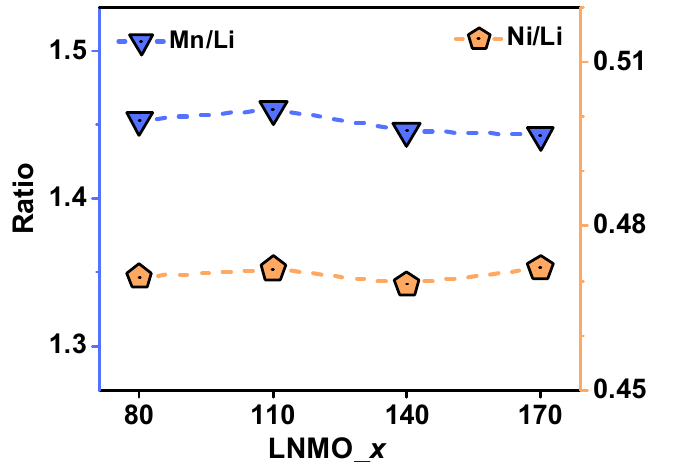
Figure 4. The atomic ratio of the Mn and Ni to Li within the LNMO_ x samples based on ICP-OES measurement results.